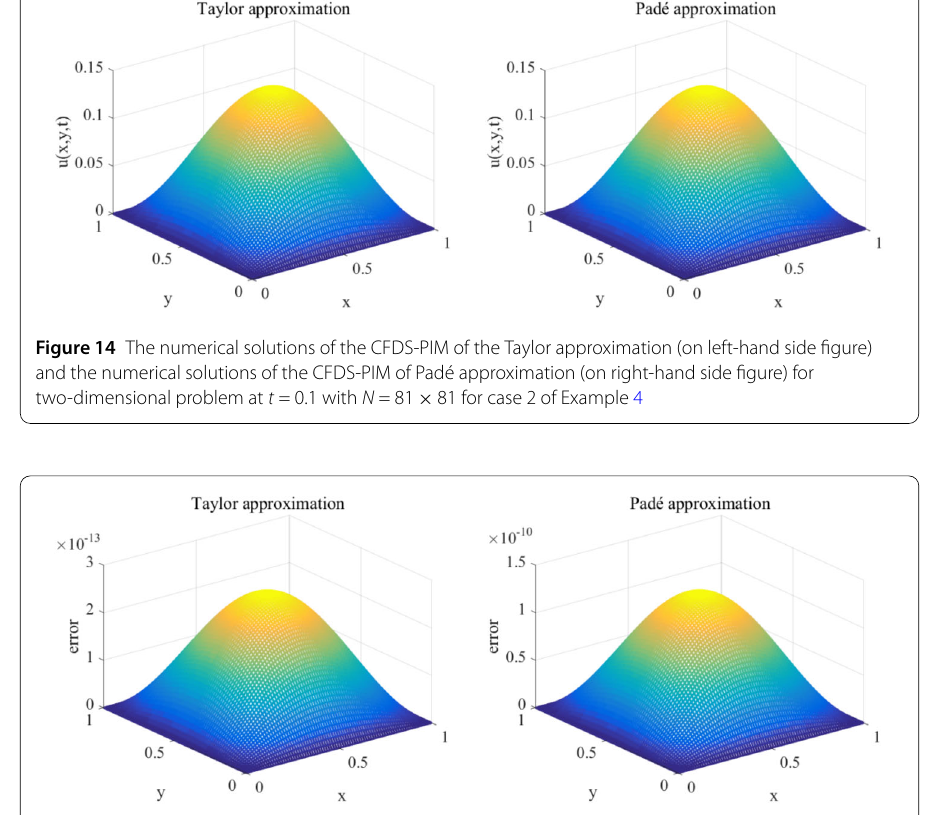
Figure 15 The errors between the exact solutions and CFDS-PIM approximated solutions of the Taylor approximation (on left-hand side figure) and the errors between the exact solutions and CFDS-PIM approximated solutions of Padé approximation (on right-hand side figure) for two-dimensional problem at t = 0.1 with N = 81 × 81 for case 2 of Example 4